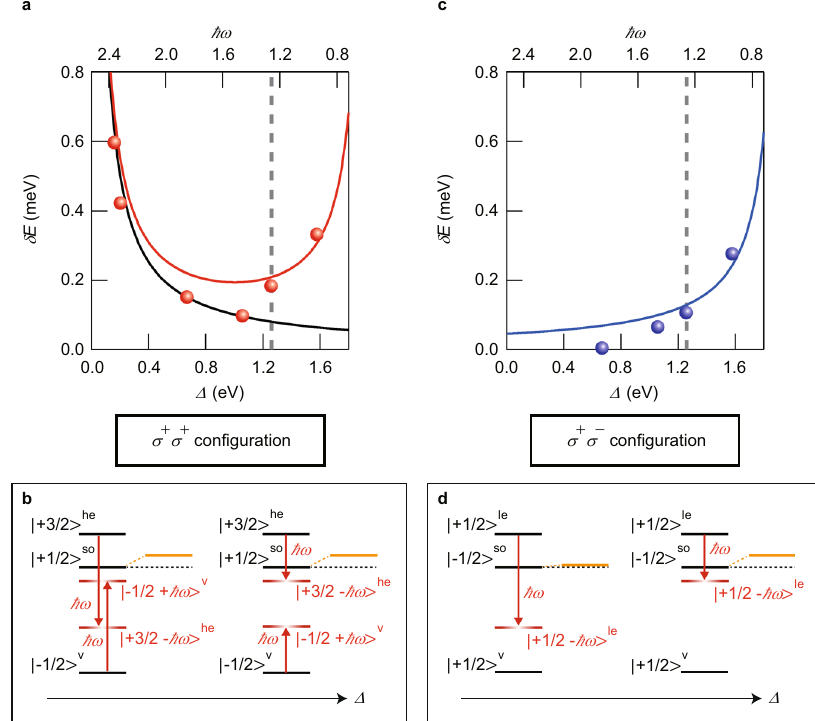
Fig. 3 Crossover from two-level OSE to ATE. a Δ dependence of the energy shift in the σ + σ + con fi guration for a pump intensity of 0.56 GW/cm 2 . The red curve shows the calculated energy shift based on the three-level system model. The black curve is the δ E Stark calculated using Eq. (1) for μ = 19 D at the corresponding pump intensity. The top scale shows the pump energy. The gray dashed line indicates half of the band-edge exciton energy. b The energy diagrams of the Δ -dependent hybridization of the photon-dressed states and the lowest CB state | + 1/2> so , which can be probed in the σ + σ + con fi guration. The orange lines represent the eigenstates after the hybridization with the photon-dressed states. The hybridizations of the other photon-dressed states with | − 1/2 > v and | + 3/2> he are not shown, for simplicity. c , d Δ dependence of the energy shift ( c ) and the corresponding energy level diagram ( d ) in the σ + σ − con fi guration.